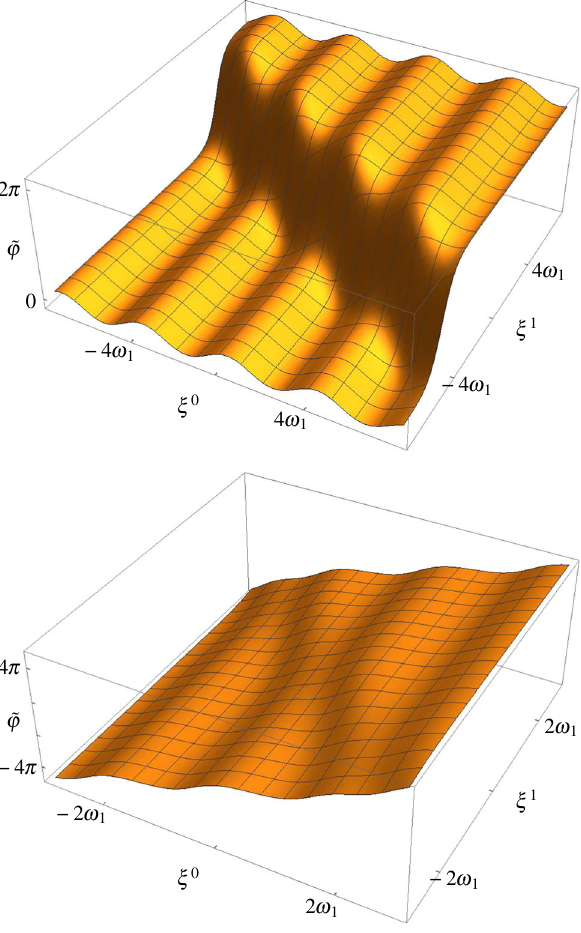
Fig. 1 The dressed sine-Gordon solution for a translationally invariant oscillating seed with E = − 9 μ 2 / 10 and a translationally invariant rotatingseedwith E = 11 μ 2 / 10.Inbothcases,theBäcklundparameter equals a = 2